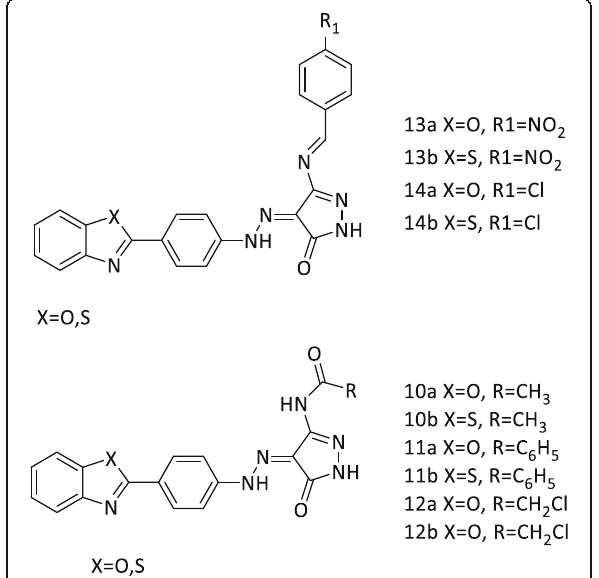
Fig. 20 Benzoxazole/benzothiazole-pyrazolinone